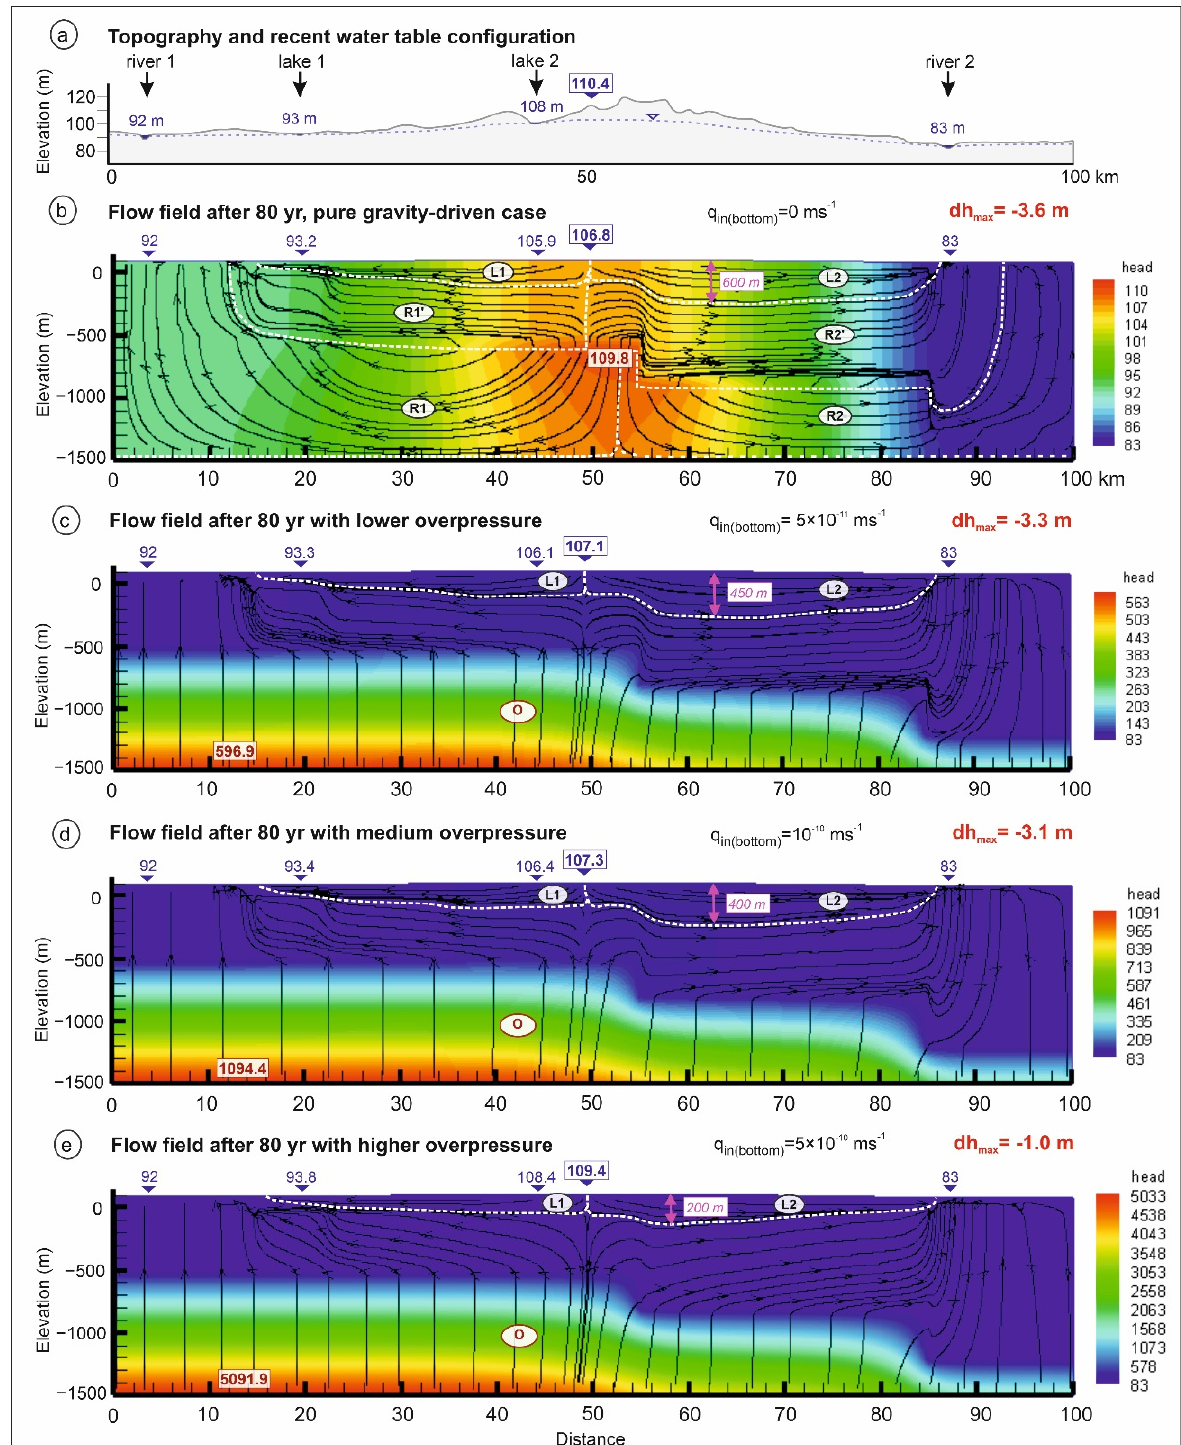
Figure 5. Comparison of the results after 80 yr obtained from transient simulation showing ( a ) recent groundwater table configuration in relation to the topography, and the quasi-steady-state hydraulic head distribution and flow pattern in case ( b ) of pure gravity-driven case, ( c ) combined driving forces with gravity and lower overpressure, ( d ) combined driving forces with gravity and moderate overpressure and ( e ) combined driving forces with gravity and higher overpressure. Hydraulic head values are colour-shaded; groundwater flow directions are indicated by black arrows; dark blue numbers represent the surface water levels (m asl); dark blue bold number in rectangle repre- sents the maximum hydraulic head along the water table (m asl); red bold number in rectangle showing hydraulic head maximum within the flow field (m asl); and dashed lines show the bound- aries of different flow systems: L1, L2, L3, L4 are local, I1 is intermediate, R1, R1 ′ , R2, R2 ′ are regional flow systems. OP represents overpressured upward flow domain. Purple arrows with numbers in rectangle showing the maximum penetration depth of the upper gravity-driven flow system. “ q in(bot- tom) ” is Darcy flux of groundwater inflow across the bottom, responsible for the development of overpressure. “d hmax ” showing the maximum hydraulic head change along the groundwater table.